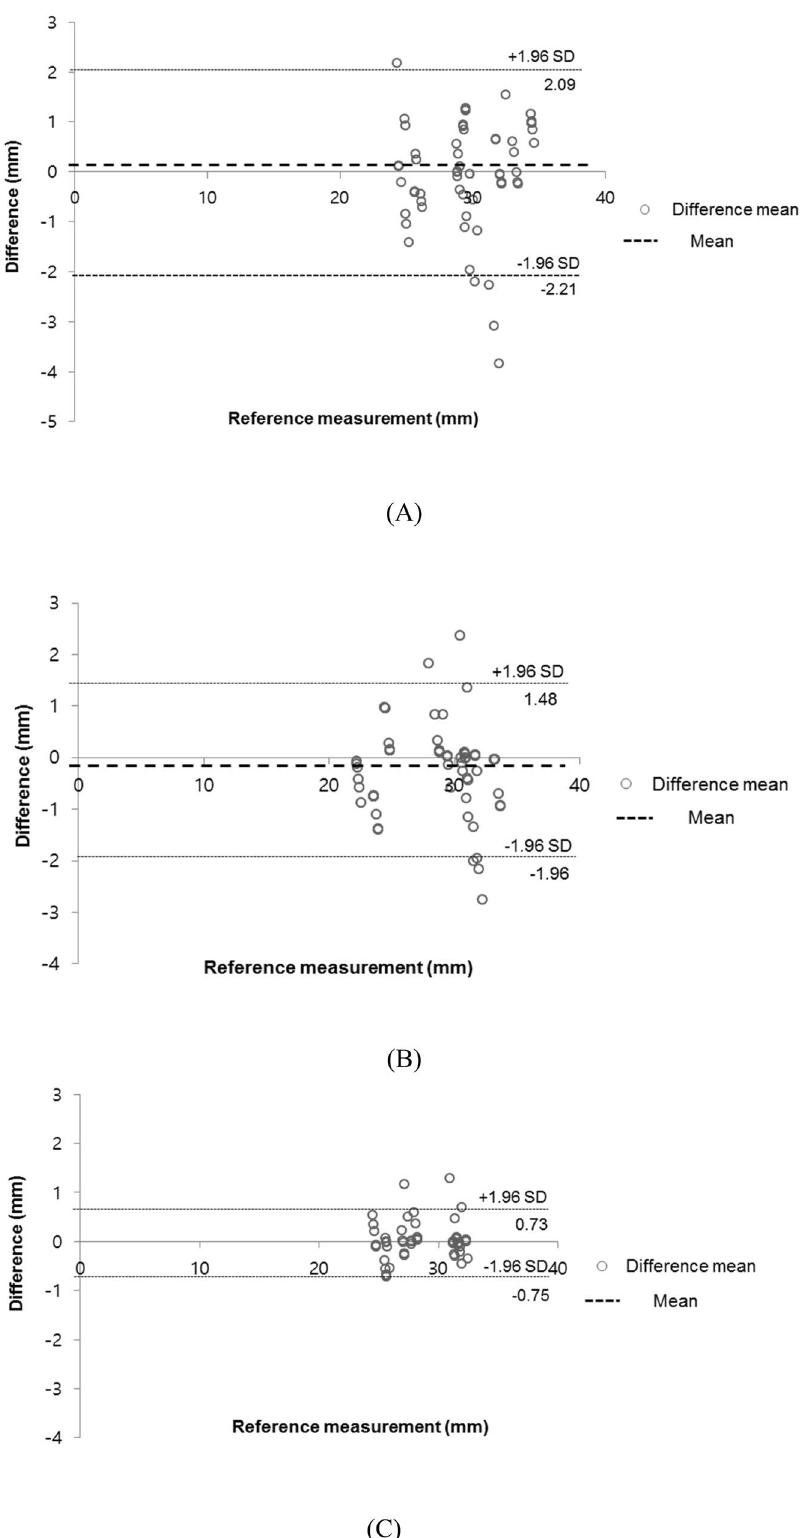
Figure 6. The Bland–Altman analysis to evaluate differences between the 3D model (STL) and the 3D-printed phantom. ( A ) Diameter of the horizontal zone, ( B ) LAA ostium, ( C ) Vertical zone. (SPSS version 25.00; IBM Corp., Armonk, NY, USA). 3D three-dimensional, STL Stereolithography, LAA left atrial